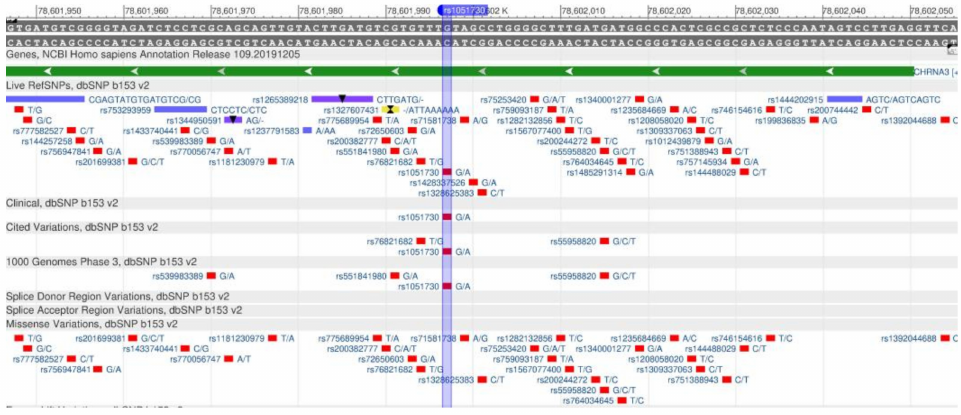
Figure 39. A region of the CHRNA3 gene (located on the long (q) arm of chromosome 15) containing the oligonucleotide polymorphism